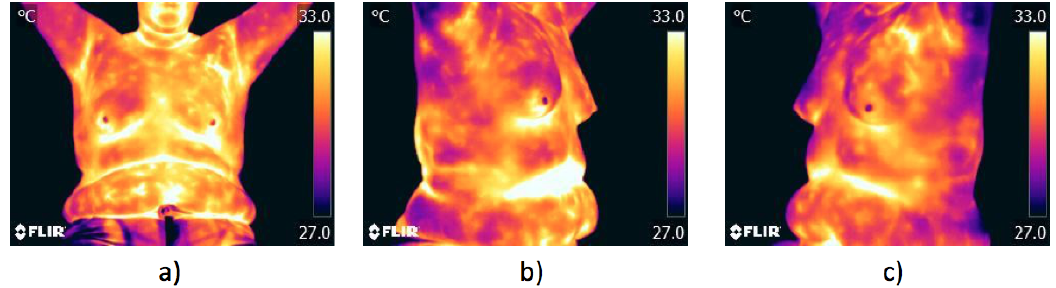
Figure 2. Thermograms acquisition: ( a ) frontal view; ( b ) right view; and ( c ) left